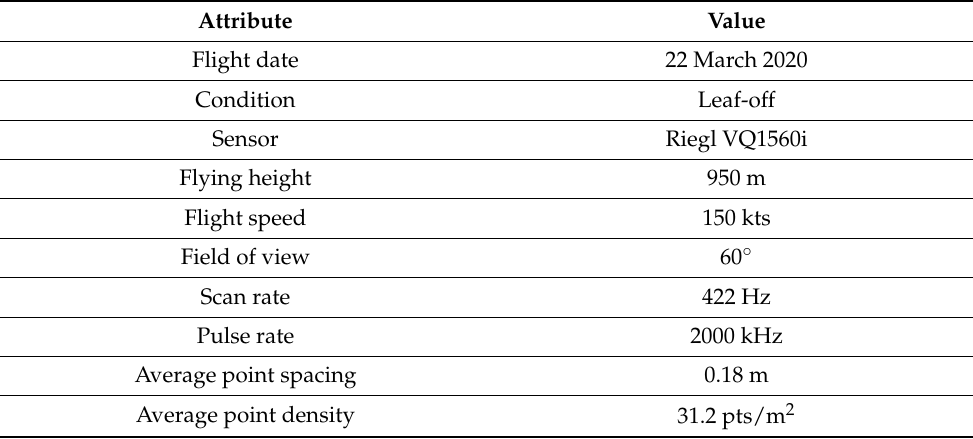
Table 1. Technical specification of the ALS data